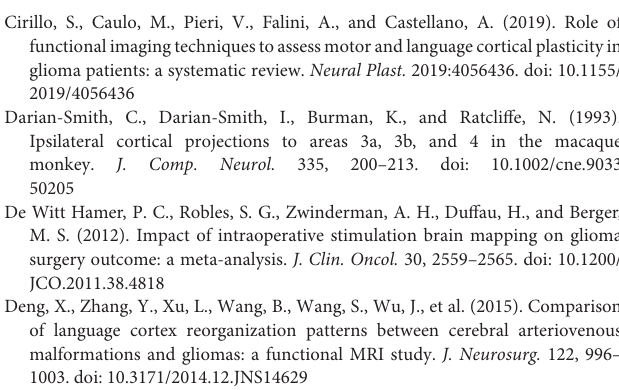
FIGURE S1 | 1st step (a) Each positive mapping sites were plotted on the 3D-brain images which is generated via MR images using iPlan Stereotaxy 3.0 software (BrainLab). The exact locations of the positive mapping sites were determined in accordance with their spatial relationships to various anatomical landmarks, such as gyri, sulci, resection cavity at the previous surgery, and so on. The plotted positive mapping sites on 3D-brain can be also automatically plotted on original 2D-MR images. 2nd step (b) Each positive mapping sites were plotted on the normalized T1-images. 3rd step: The spatial location of the positive motor mapping sites were overlaid on the 3D MNI brain using the MRIcroGL software, and then they were re-checked the anatomical location comparing with operative record. A, anterior; P, posterior; M medial. Upper column (A): Black triangles, central sulcus; blue triangles, superior frontal sulcus; star, resection cavity in the first operation; yellow circled region, positive motor responses elicited by the DES. Lower column (B): Black triangles, central sulcus; blue triangle, inferior frontal sulcus; white triangles, sylvian fissure; yellow circled region, positive motor responses elicited by the DES. FIGURE S2 | These images present additional information for Case 7 and 8 in the previous surgery. The left column shows the preoperative MRI, and the middle column shows the preoperative fMRI. The right column presents the final view of the previous surgery. During awake surgery, motor sites were positively mapped in the precentral gyrus in both cases (yellow circled region). Red triangles: central sulcus; broken line in rightward column: central sulcus; NMR: negative motor response; A: anterior; P: posterior; M: medial side. FIGURE S3 | Functional shift depending on surgical history and lesion. We investigated whether the motor area was moving or being stable based on (A) the surgical history and (B) tumor location. The results revealed that reorganization tended to occur with high probability after the second or subsequent surgeries. When glioma cells expanded into Brodmann’s area (BA) 4, all patients experienced motor functional shift. In contrast, patients whose tumor locations were not in BA 4 or BA 6 did not experience functional